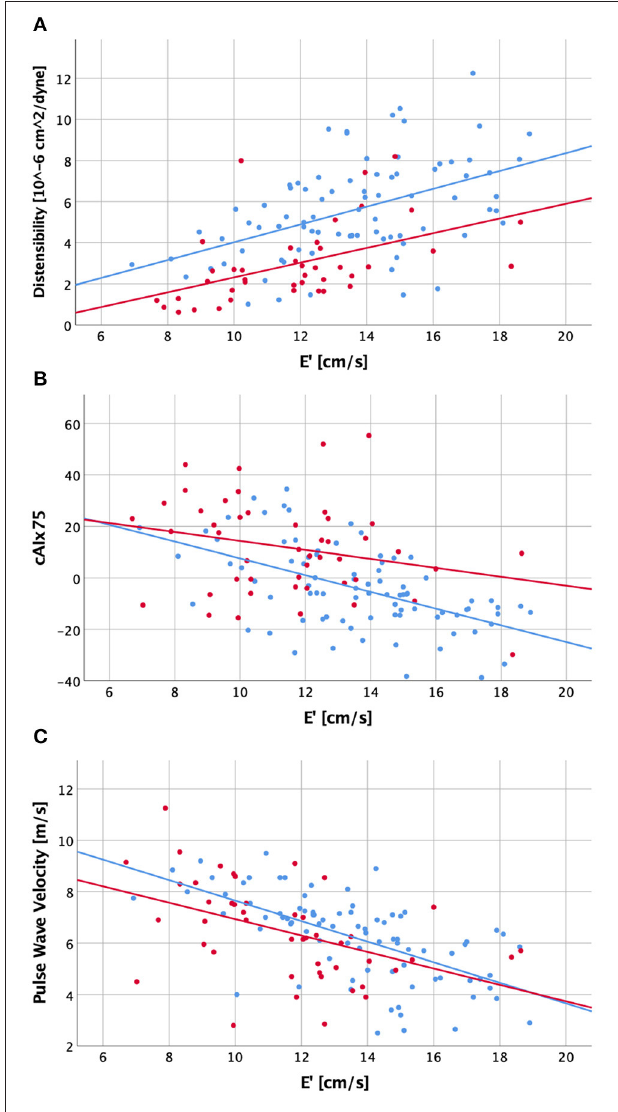
FIGURE 1 | Scatter plot visualizing correlations between diastolic function (E’) and ascending aortic distensibility (A) , central augmentation index corrected to a heart rate of 75/min [cAIx75; B ] and carotid-femoral pulse wave velocity (C) for patients with a history of bicuspid aortic valve (red dots and regression line) and healthy controls (blue dots and regression